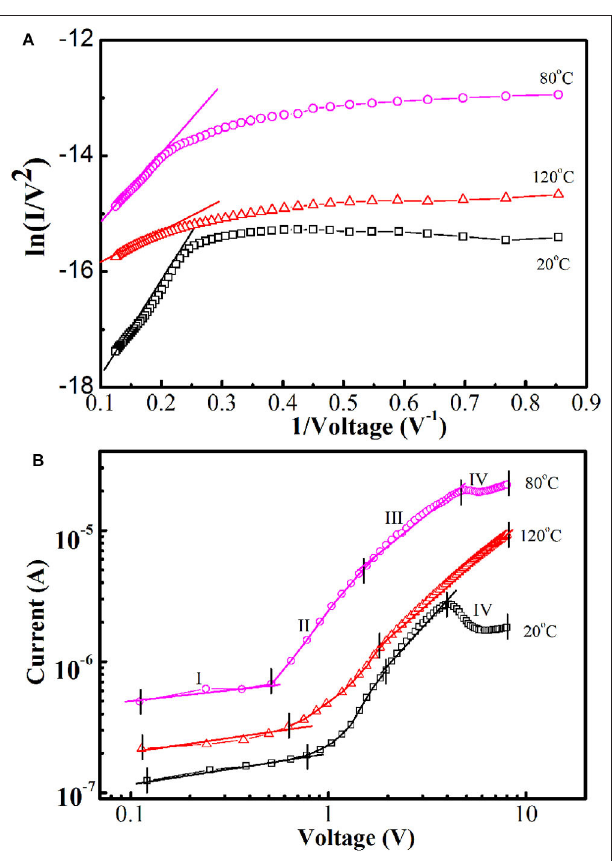
FIGURE 5 | (A) Plots of ln (I/V 2 vs. 1/V). (B) log I–log V plots of n-ZnO NRs/p-degenerated diamond heterojunction at 20–120 ◦ C.